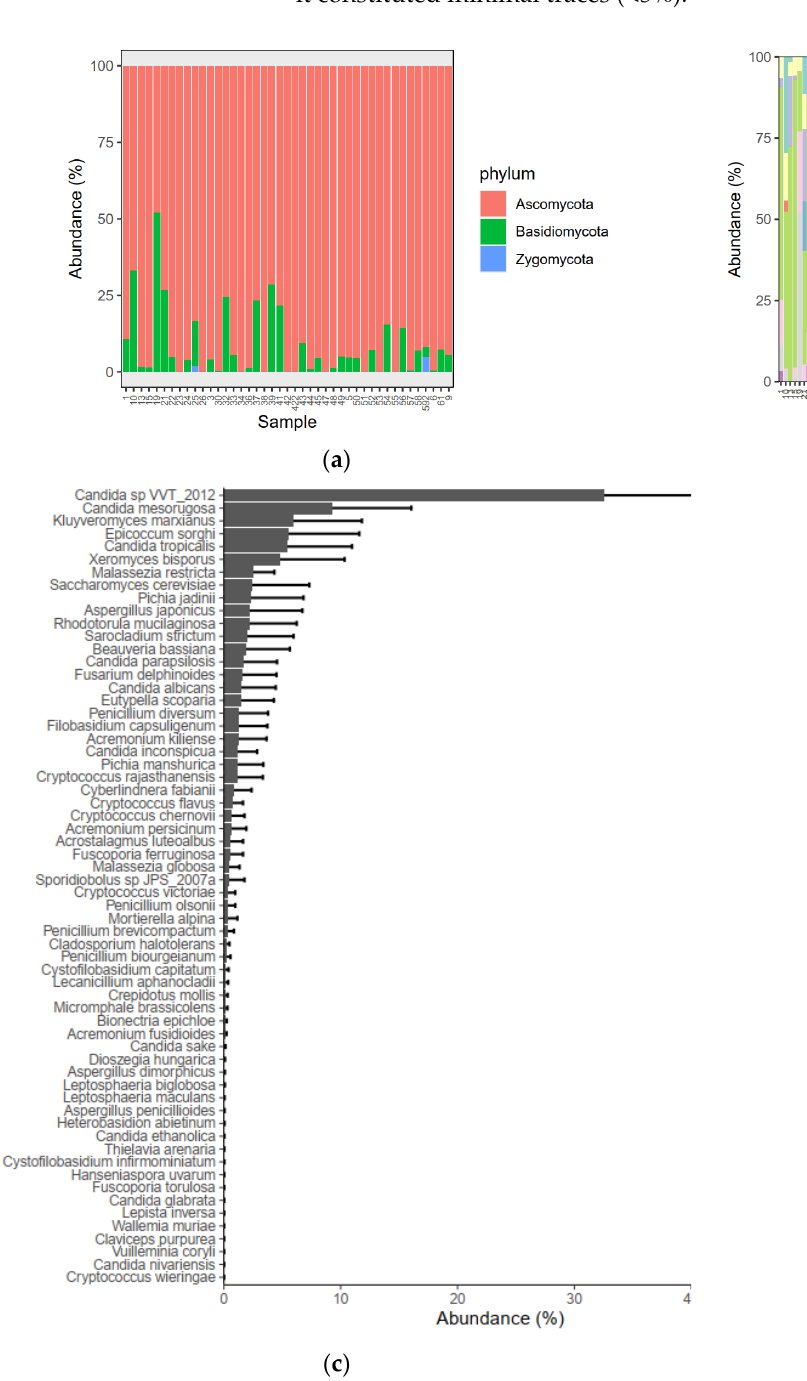
Figure 5. Bar and stacked bar plots showing relative percentage abundances of mycobiome taxonomic bins in ITS gene sequence datasets: the phylum ( a ) and class levels ( b ) are shown individually, while the species level is shown as means across the cohort ( c ). The most abundant fungal species are displayed. Cutoff for taxon inclusion = 0.01%.